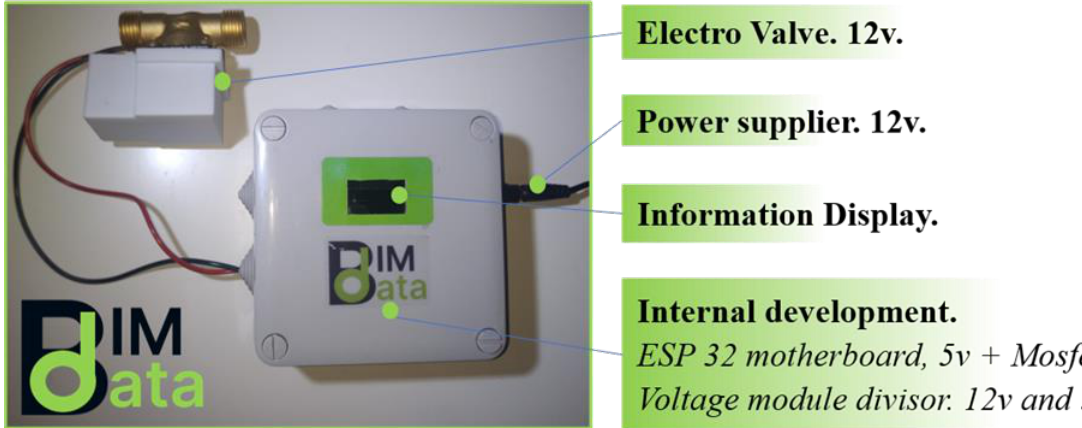
Figure 12. Hardware developed. BIM DATA SL.